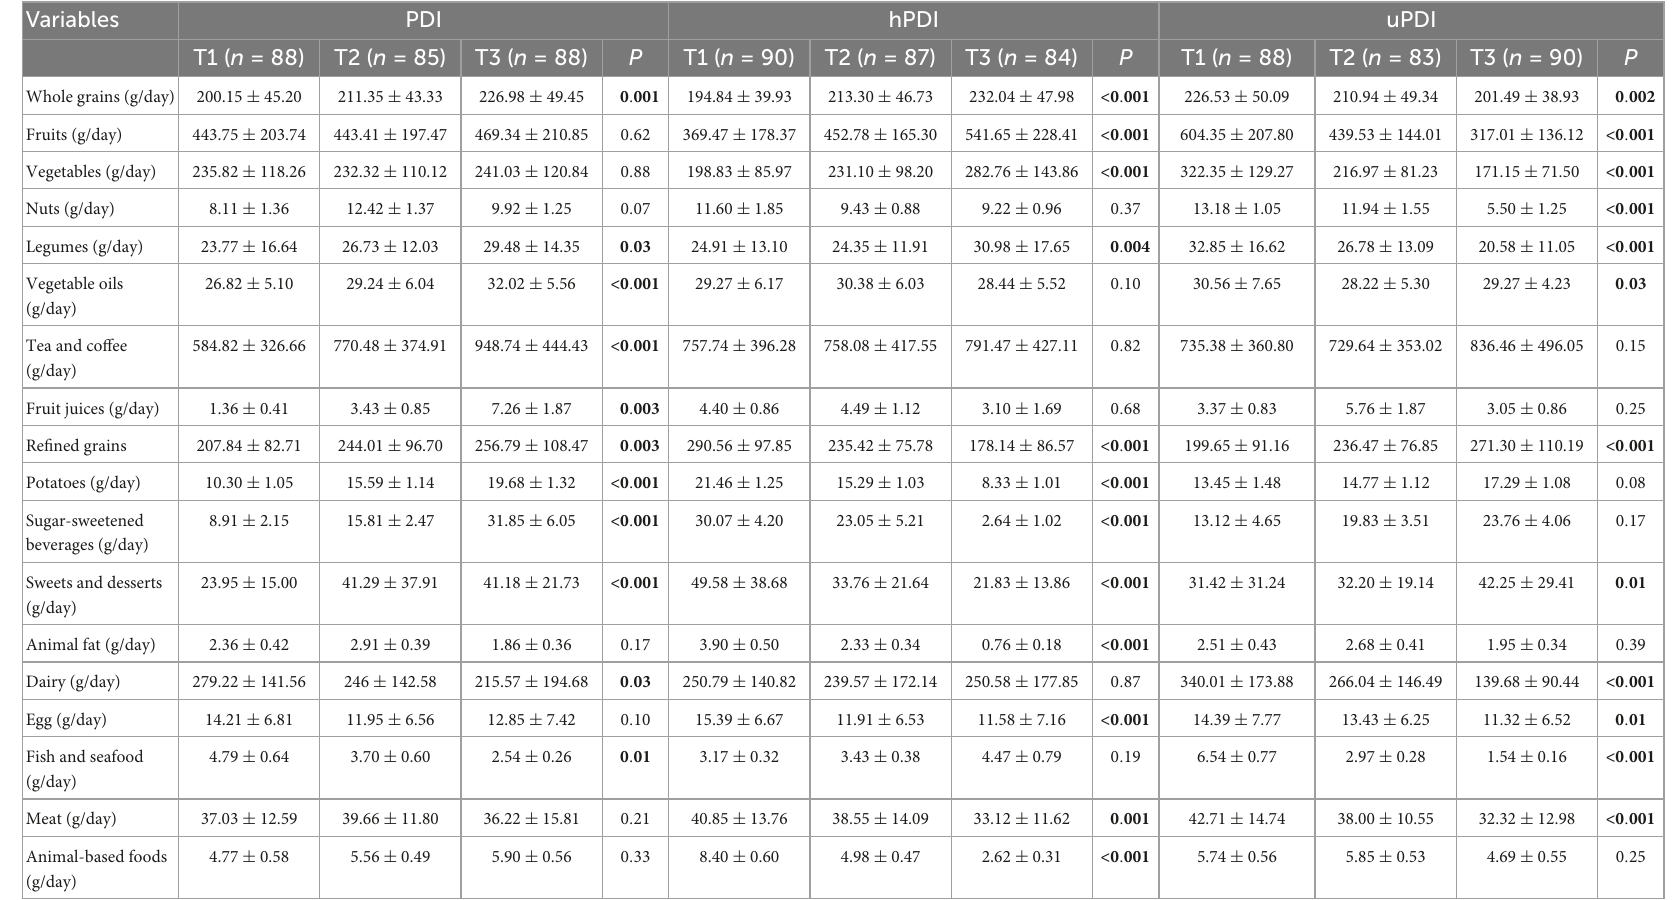
TABLE 3 The intake of food groups between tertiles of plant-based diet index (PDI), healthy plant-based diet index (hPDI), and unhealthy plant-based diet index